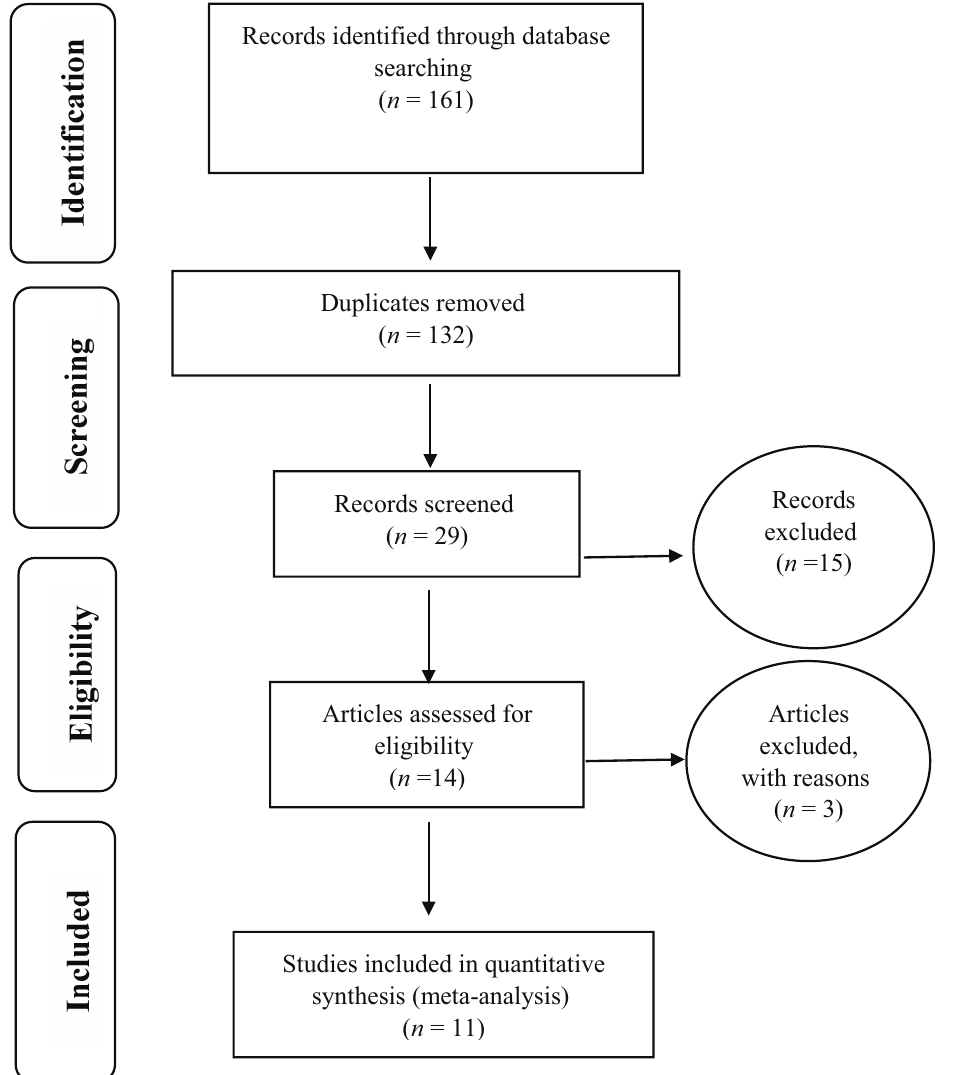
Figure 1. Flow chart of the review process and selection and separation of studies based on